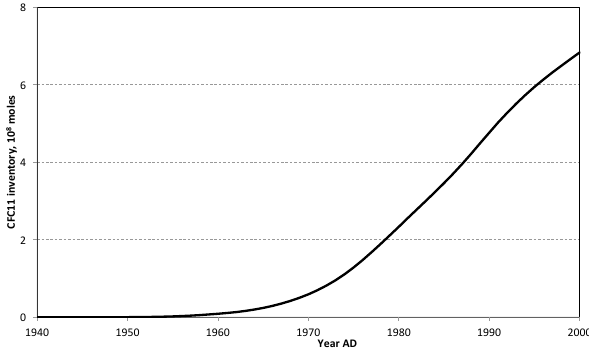
Fig. A3. Simulated oceanic carbon uptake (GtCyr − 1 ) for the period